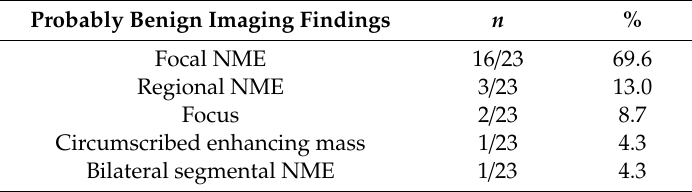
Table 3. Probably benign imaging findings (Breast Imaging Reporting and Data System or BI-RADS 3) on iodine images only.